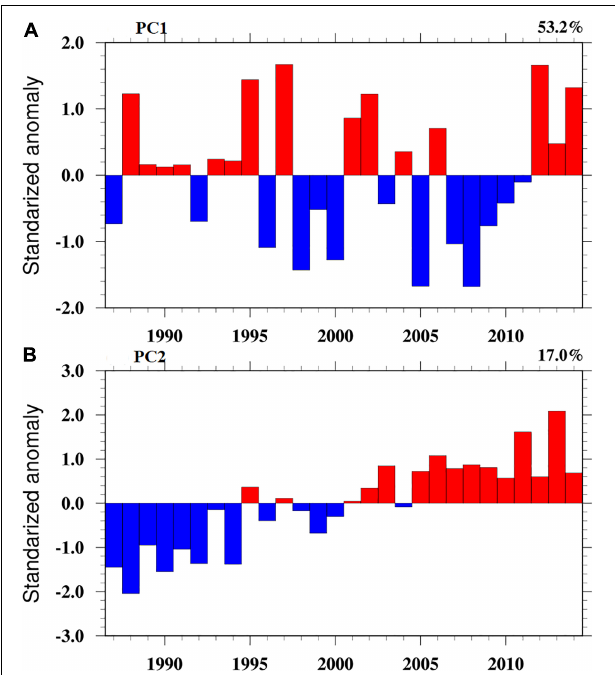
FIGURE 5 | (A) The first Principal Component associated with EOF1 (PC1) and (B) The second Principle Component associated with EOF2 (PC2) of winter precipitation over Nepal, based on APHRODITE data from 1987 to 2015. TABLE 1 | Correlation between two modes of EOF and winter precipitation. EOF Correlation EOF1 0 . 97 ( p < 0 . 05 ) EOF2 − 0 . 13 ( p = 0 . 50 )